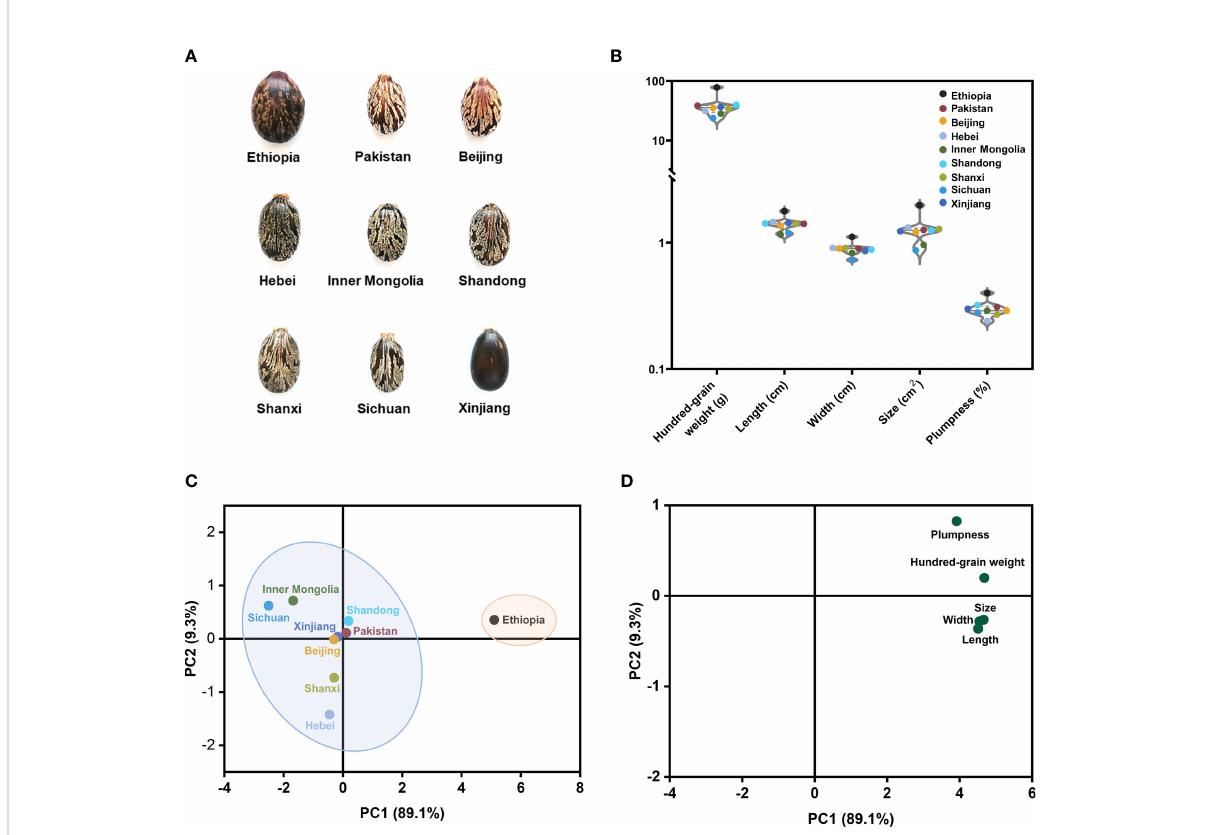
FIGURE 6 Phenotype description and PCA analysis of castor beans from nine different sources. (A) Appearance and morphology of castor beans; (B) Violin plot of fi ve phenotypic traits of castor beans. Score plot (C) and loading plot (D) of the PCA analysis model based on fi ve features of castor beans from different geographical